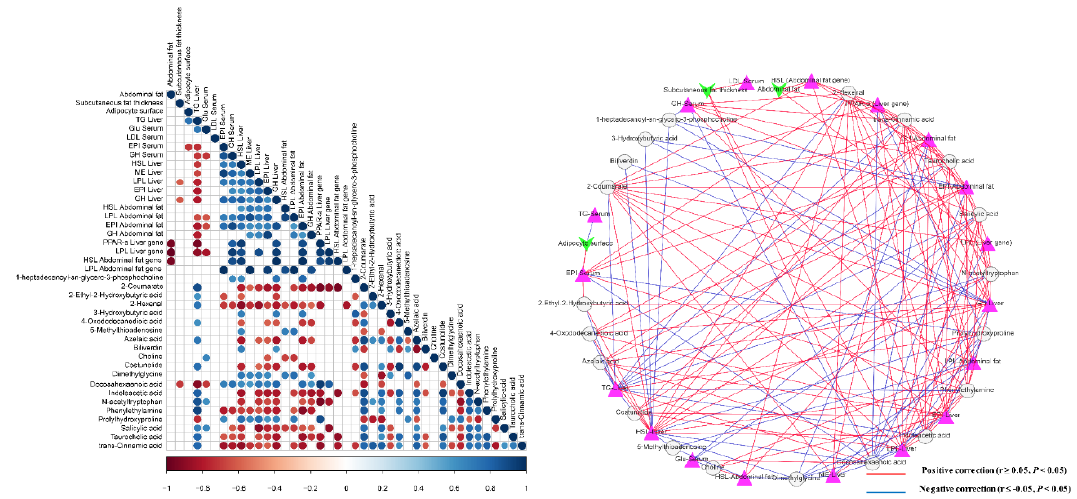
Figure 4. (The original image is presented in supplemental material). Correlation and co-occurrence network analysis among fat deposition, lipid-related indices, and predominant serum metabolites. ( a ) Correlation among fat deposition, lipid-related gene expression, and predominant serum metabolites. Correlation between fat deposition and lipid-related indices, and predominant serum metabolites. Cells are colored based on Spearman’s correlation coefficient: red represents a negative correlation, and blue represents a positive correlation. ( b ) Co-occurrence network analysis among fat deposition, lipid-related gene expression, and predominant serum metabolites. Each co-occurring pair among fat deposition, lipid-related gene, and serum metabolites has an absolute Spearman rank correlation above 0.55 [blue line, positive correlation (r ≥ 0.55); red line, negative correlation (r ≤ −0.55)] with a FDR-corrected significance level under 0.05. Fat deposition shown by green vee nodes, lipid-related indices are shown by pink triangle nodes, and metabolites are shown by gray round nodes.